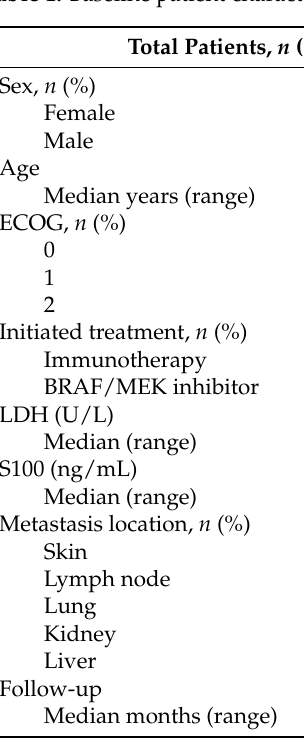
Table 1. Baseline patient